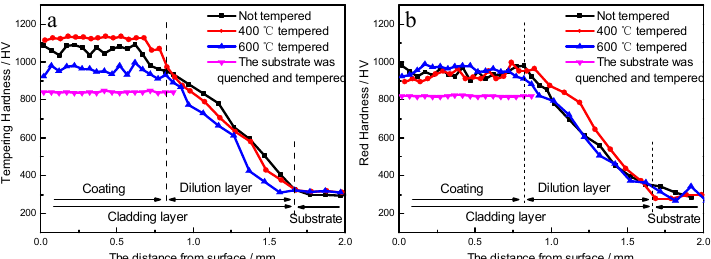
Figure 13. Hardness of cladding layer: ( a ) the hardness of tempered sample; ( b ) the hardness after holding at 600 °C for 4 h.